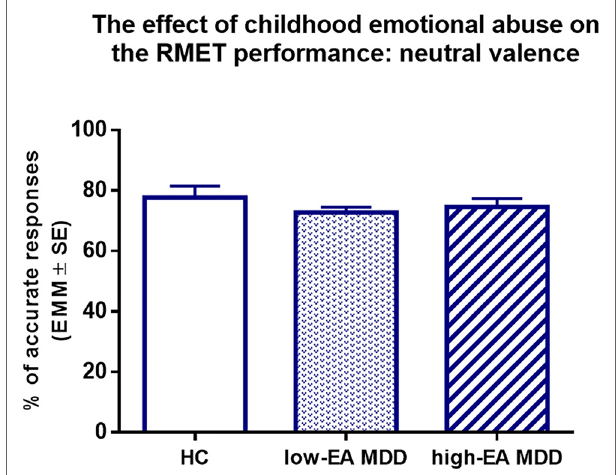
FIgURe 5 | Results of one-way ANCOVA with age, sex, and years of education as covariates. Estimated marginal means (EMM) are presented. MDD patients with moderate or severe childhood emotional abuse performed significantly worse in the negative valence compared to healthy controls and MDD patients without moderate or severe emotional abuse. EA: Emotional Abuse, HC: healthy control group, Low-EA MDD: a subgroup of MDD patients without moderate or severe childhood emotional abuse, High-EA MDD: a subgroup of MDD patients with moderate or severe childhood emotional